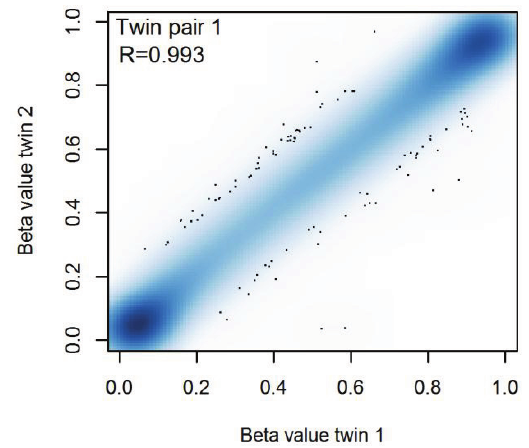
Figure 5. Smooth scatterplot of DNA methylation levels (β -values) at 420,921 CpGs in buccal cells from a monozygotic twin